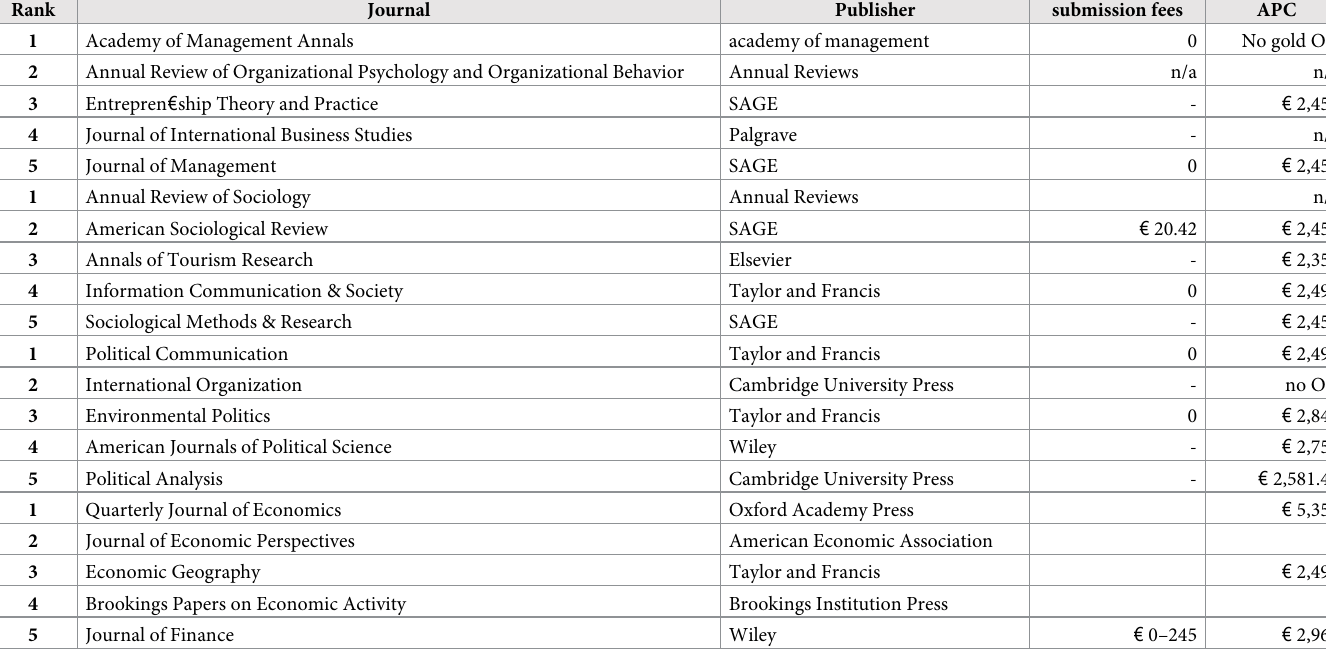
Table 5. Publication costs for top social science